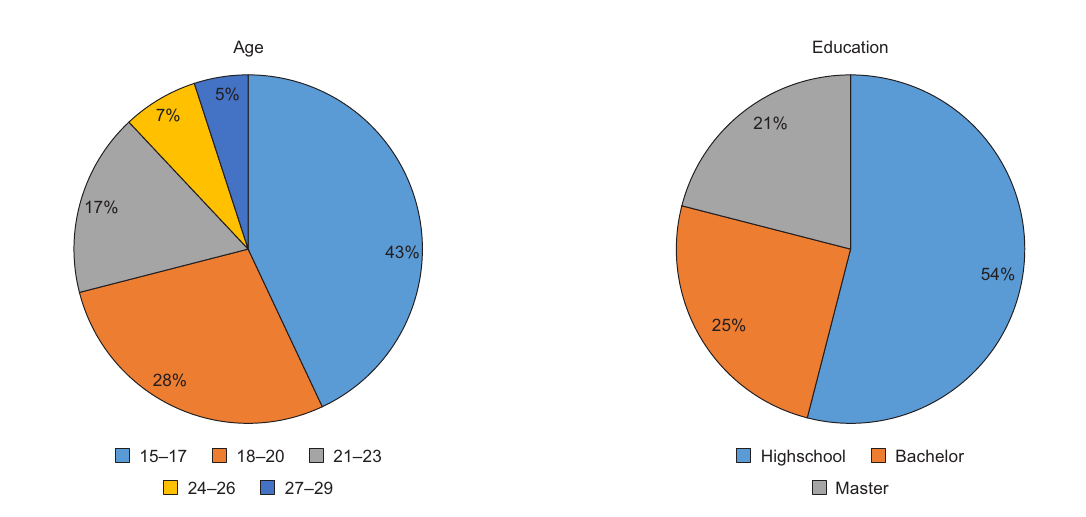
Fig. 6. Age and education level of respondents.